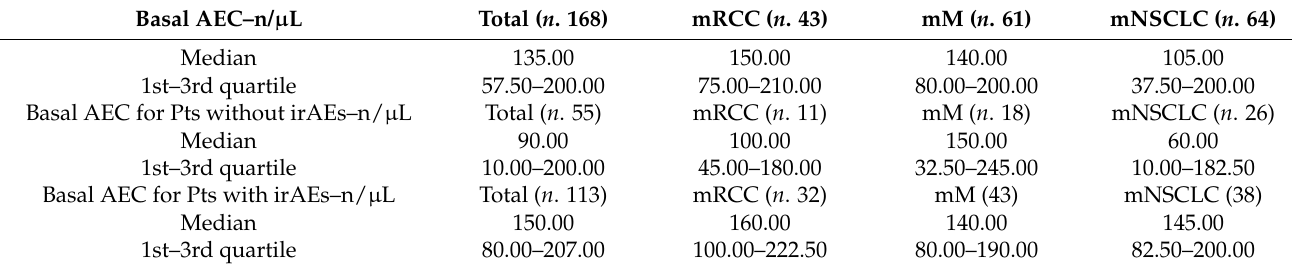
Table 3. Basal AEC in patients with irAEs and without irAEs.